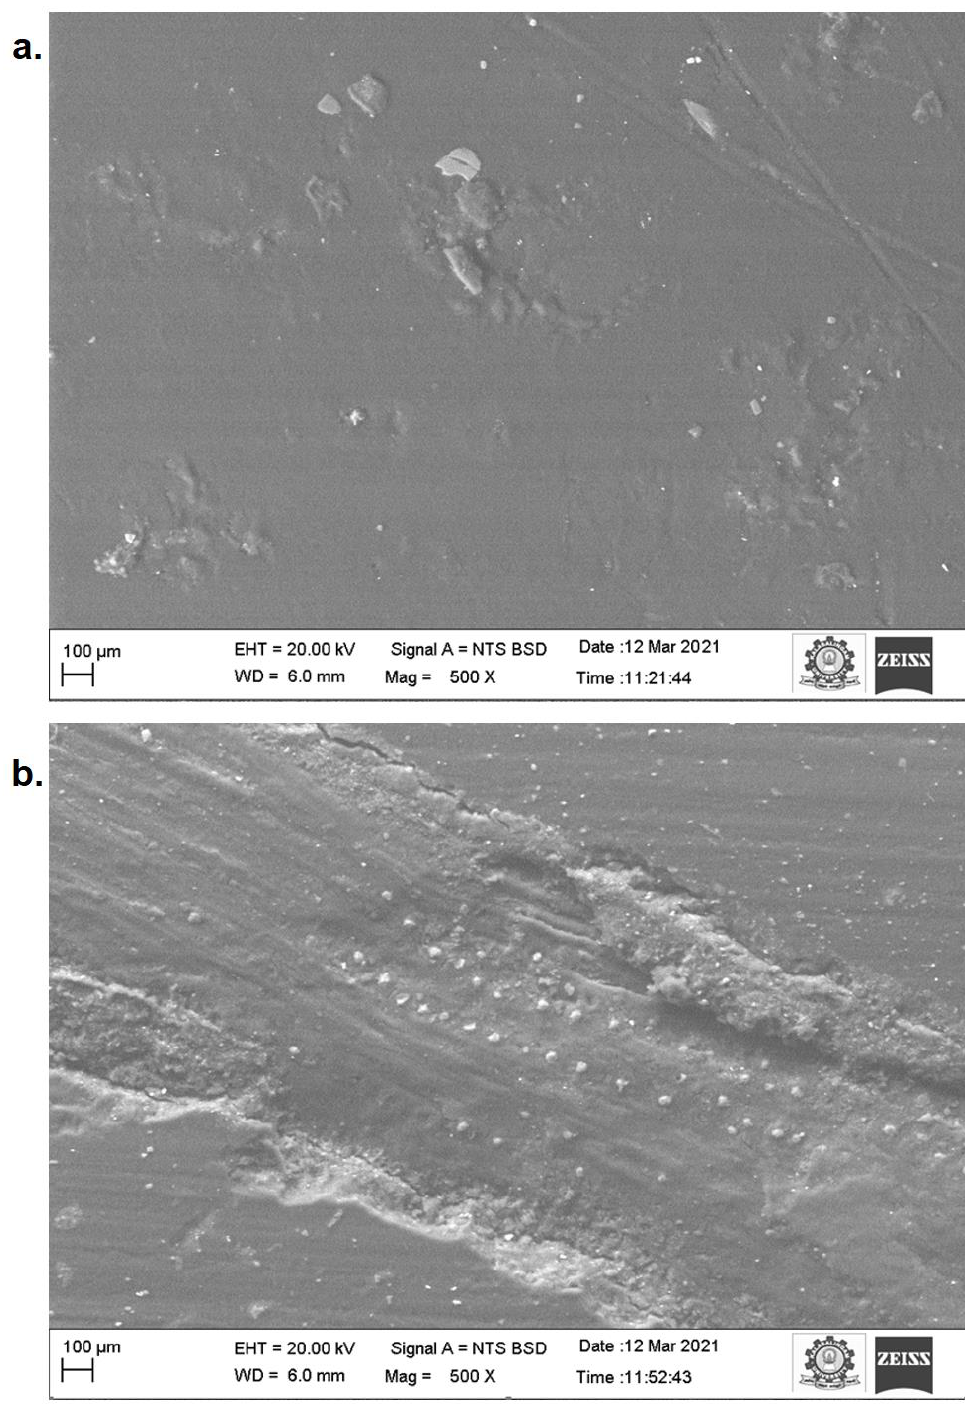
Figure 5. Sample with high COF and high wear rate (sample n.6): ( a ) Before wear test; ( b ) After wear test.